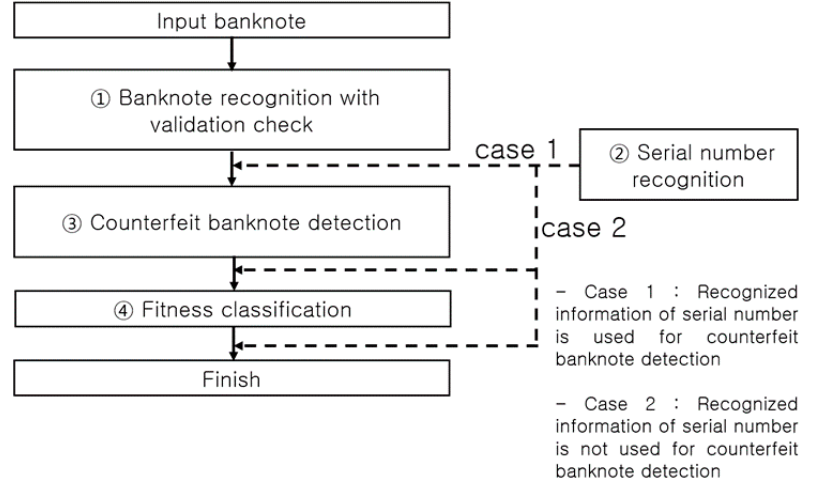
Figure 4. Banknote recognition process flow in an automated device.